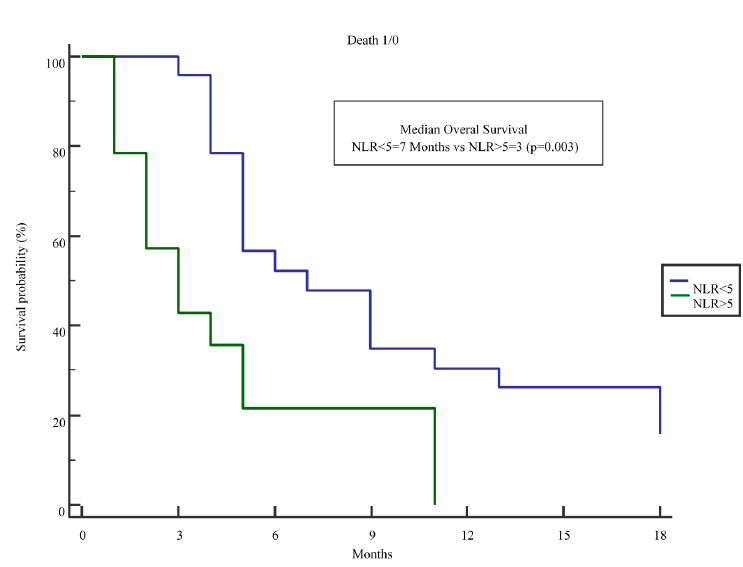
Figure 2. Kaplan–Meier analysis of the OS of 39 Stage IV pancreatic cancer patients receiving standard palliative chemotherapy with gemcitabine- or 5-fluoracile-based regimens, with an NLR higher or lower than 5.